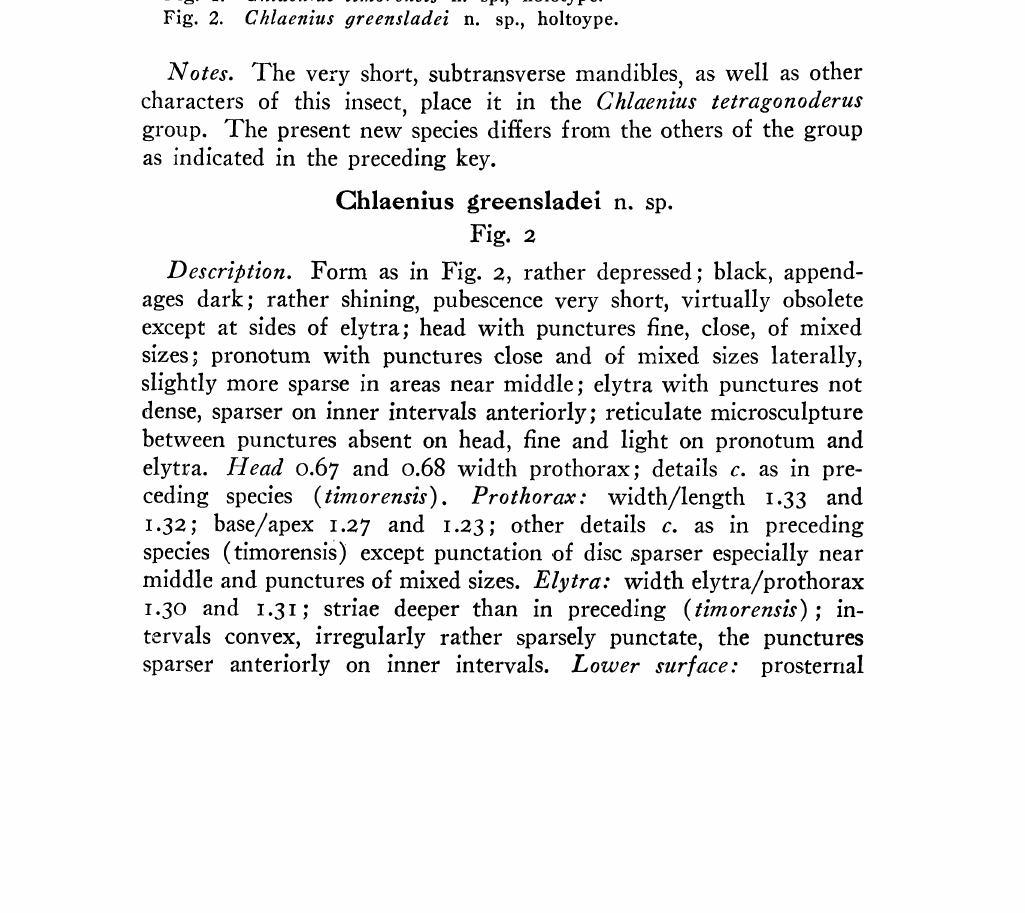
Fig. 1. Chlaenius timorensis n. sp., holotype. Fig. 2. Chlaenius greensladei n. sp.,